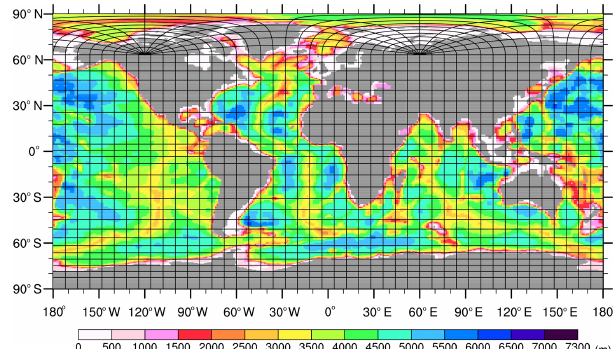
Figure 2. Horizontal grid coordinate system and model bathymetry of the ocean component of